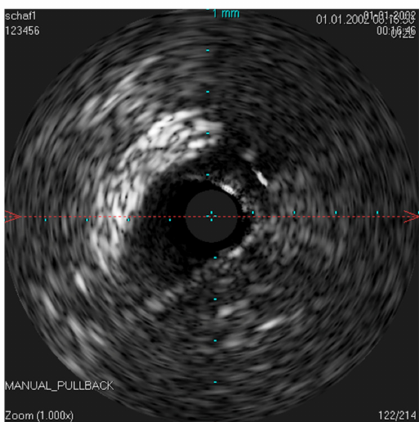
Figure 3. Sonographic image of the ET lumen flushed with water, near to the ET isthmus. The lumen now appears spindle